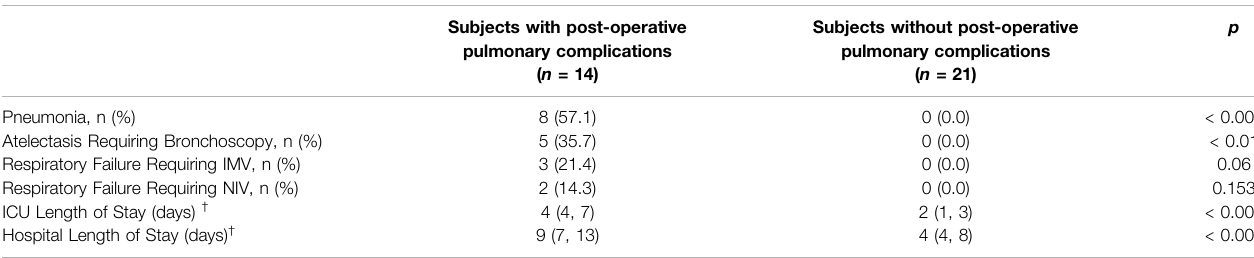
TABLE 4 | ICU, hospital length of stay, and types of post-surgical